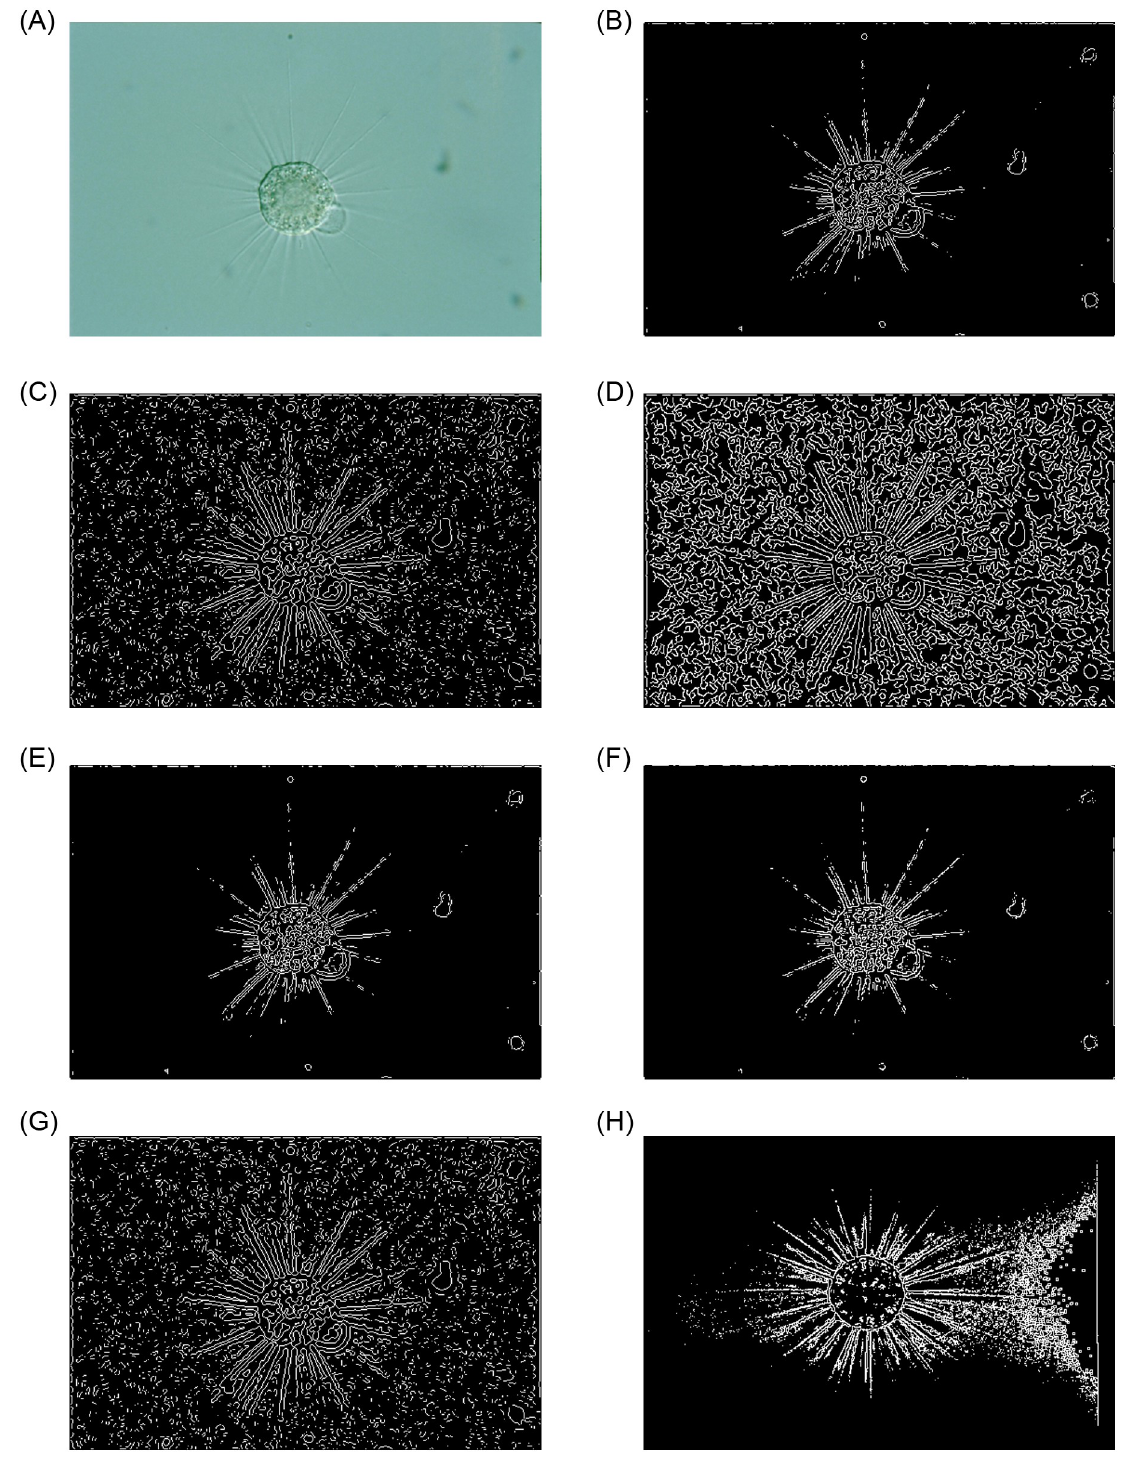
Fig 4. An example of seven edge detection results using EMDS-5 images.